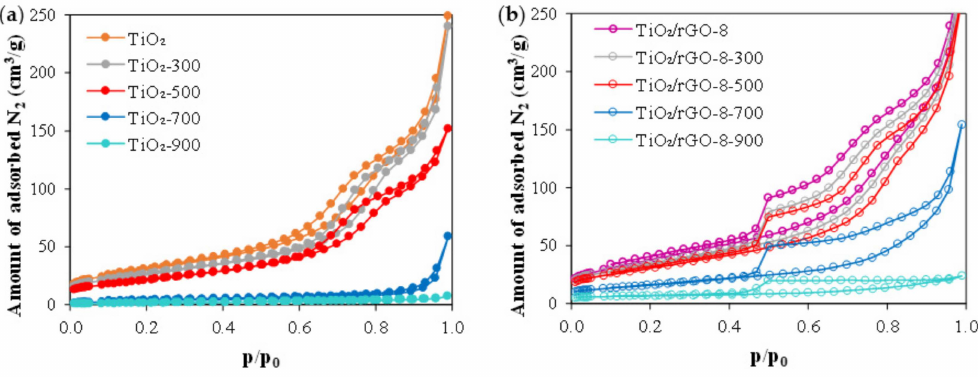
Figure 3. Adsorption–desorption isotherms for ( a ) reference, control, and ( b ) obtained